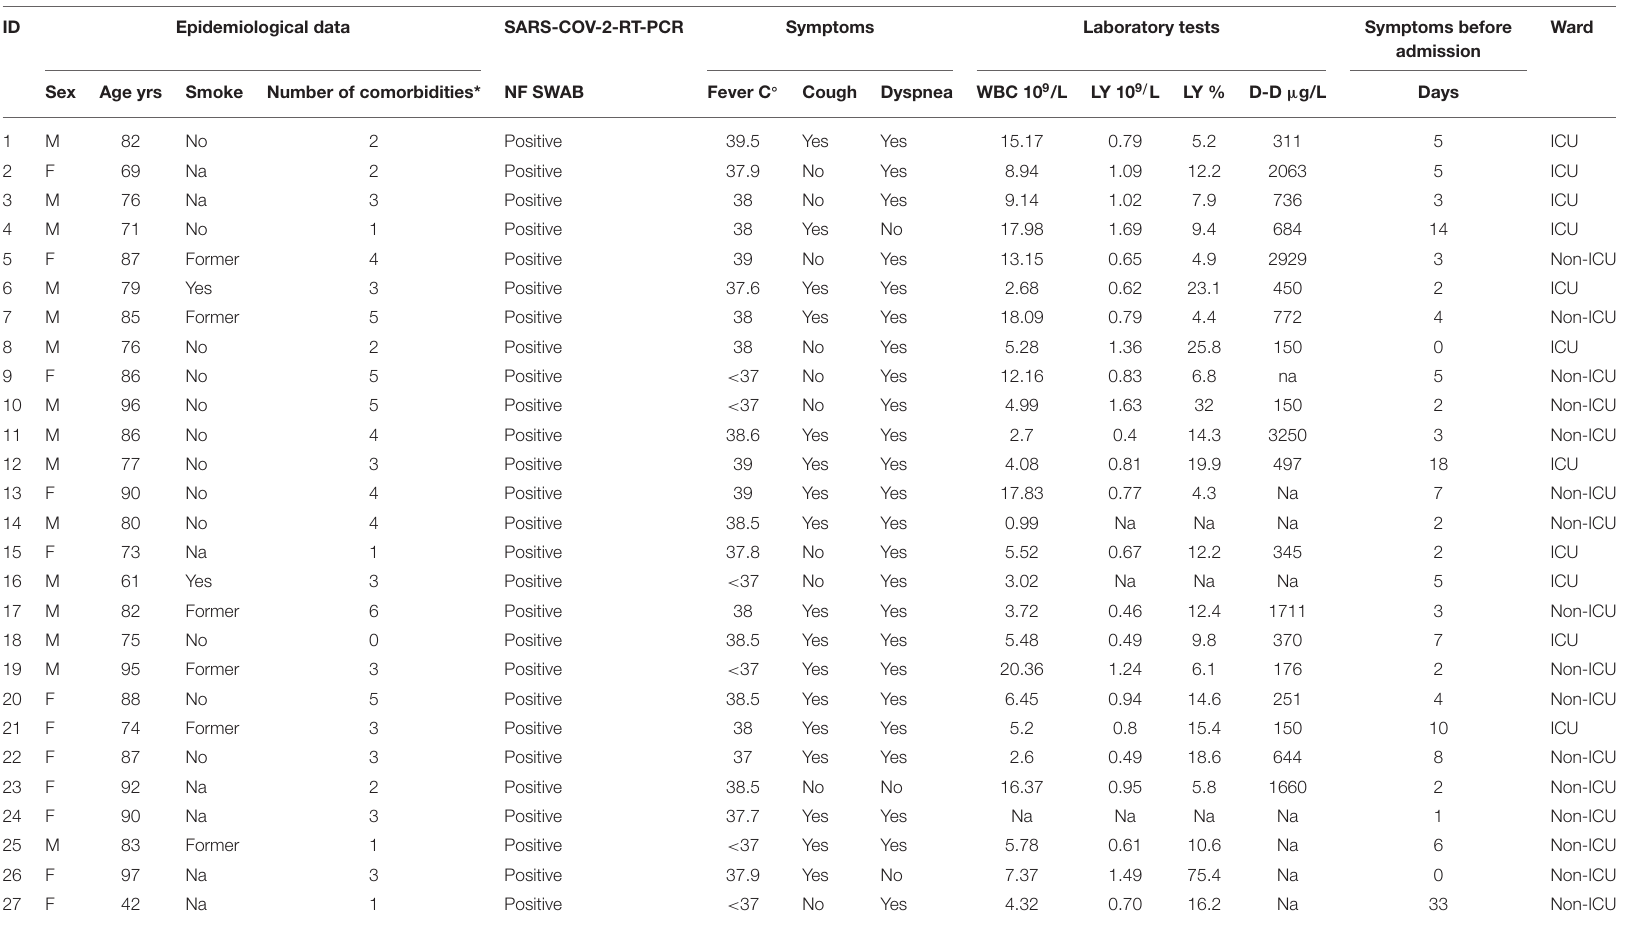
TABLE 1 | Main clinical, epidemiological, and laboratory data available for all patients. ID Epidemiological data Symptoms before